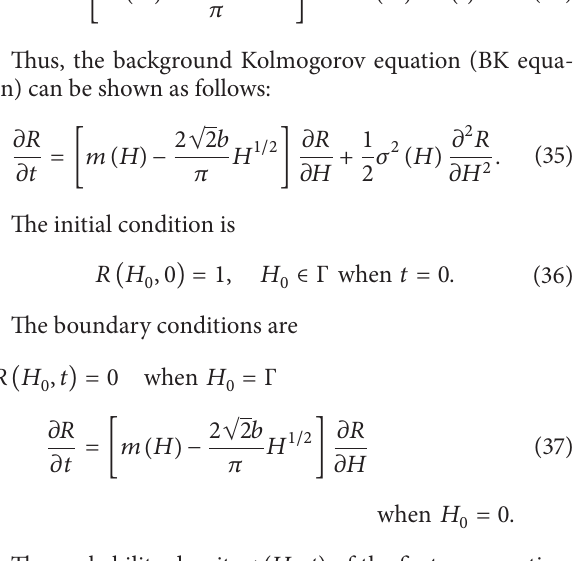
Figure 8: Reliability function of the system.